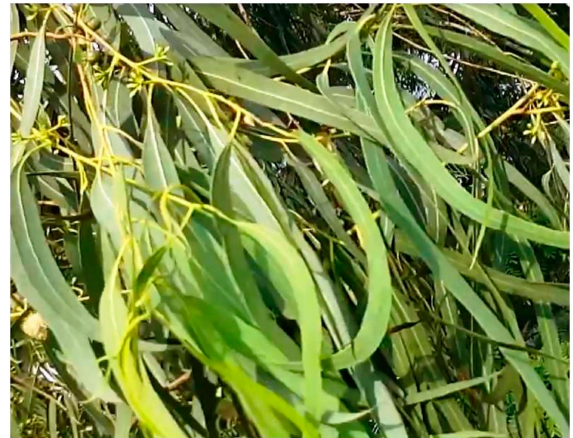
Figure 1. Eucalyptus globules leaves, collected from Jamin Pallavarm Vels University, Chennai used for the synthesis of